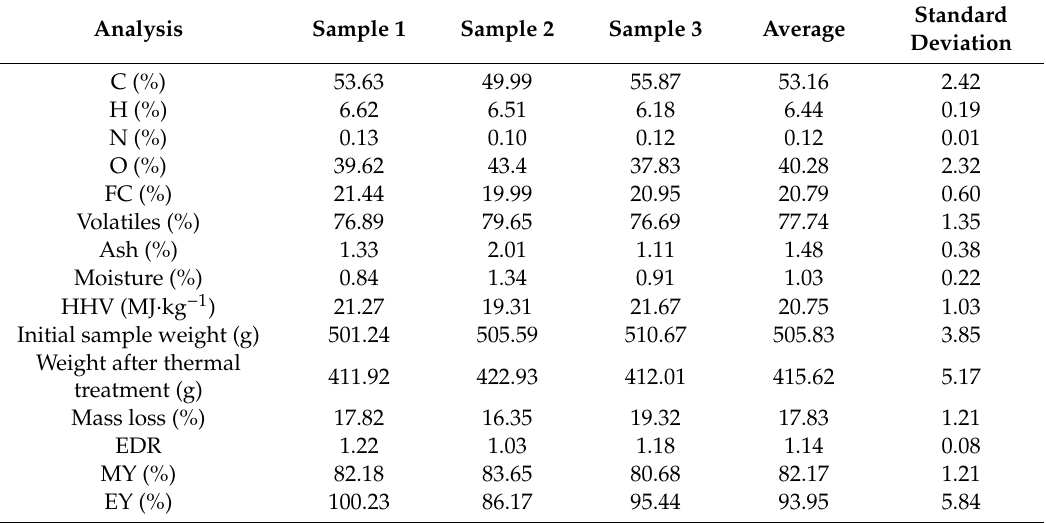
Table 5. Results obtained in analysis conducted with samples thermally treated at 200 ◦ C. EDR, energy densification ratio; MY, mass yield; EY, energy yield.